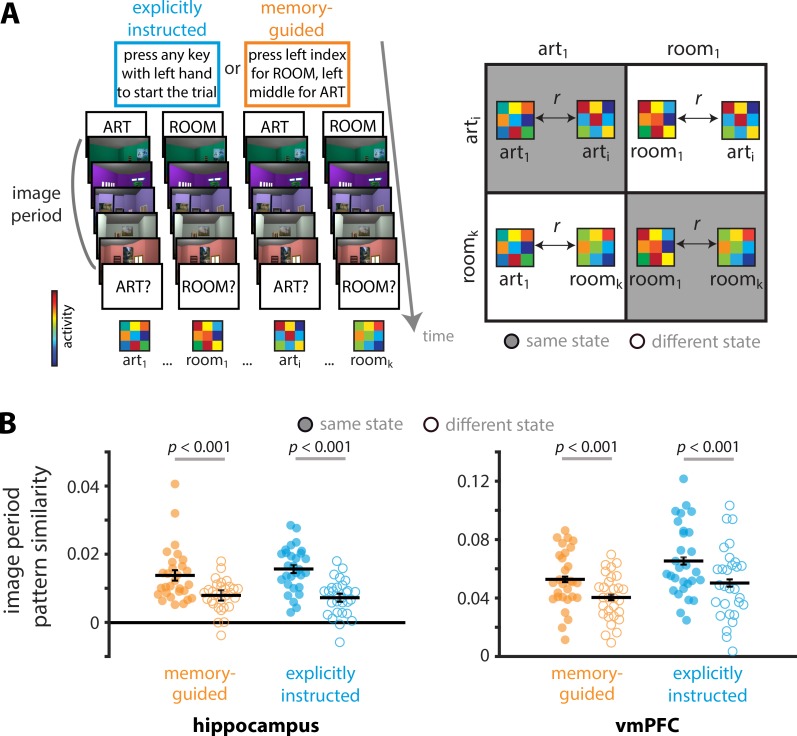
Representations of current attentional states.(A) Image period pattern similarity was calculated by correlating activity patterns across trials of the same vs. different attentional states, separately for each task. Here art1, room1, arti, and roomk indicate 1st art trial, 1st room trial, ith art trial, and kth room trial within a given task (memory-guided, explicitly instructed) respectively. Correlations were compared for trials of the same attentional state (i.e., art-art and room-room; right panel, gray background) and trials of different attentional states (i.e., art-room; right panel, white background). (B) Both the hippocampus and vmPFC represented current attentional states, with higher pattern similarity for trials of the same vs. different attentional states. Full circles and empty circles show pattern similarity for each participant for trials of the same state and different state, respectively. Solid lines show average pattern similarity across individuals. The results are shown as Pearson correlations, but statistical tests were performed after applying the Fisher transformation. The error bars indicate standard error of the mean for the within-participant attentional state difference (i.e., same - different) for each task.